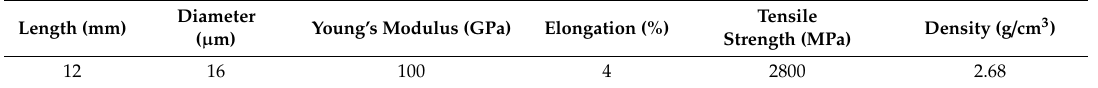
Table 2. Properties of basalt fiber